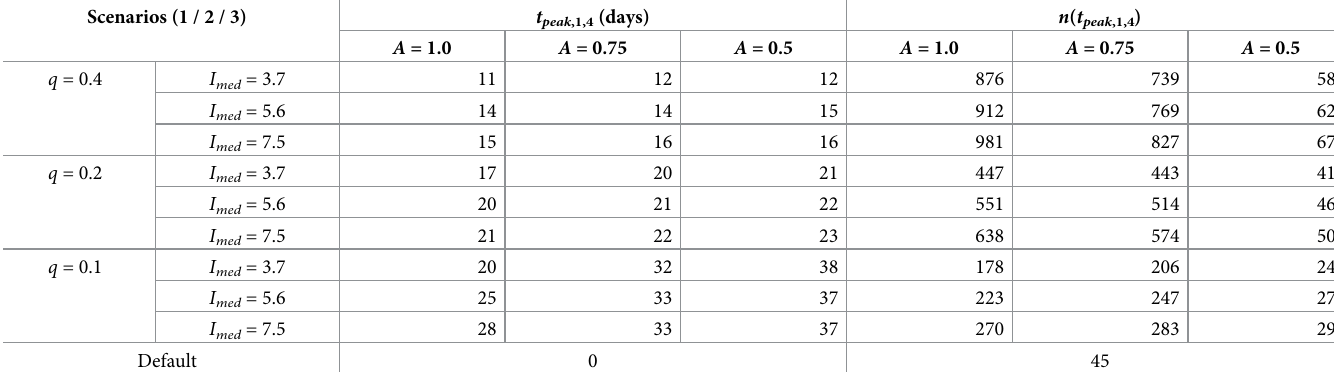
Table 6. Demonstration of the effects of detection rate. Scenarios (1 / 2 /